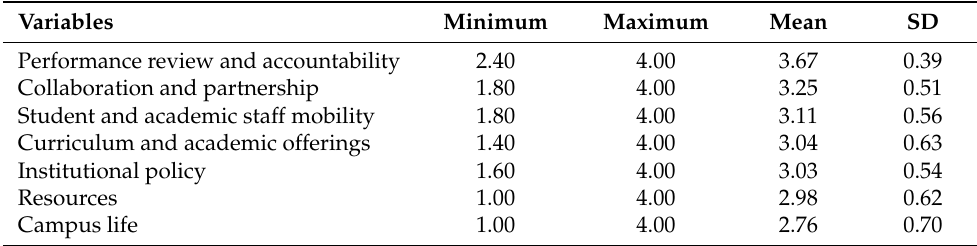
Table 2. Perceptions toward the seven performance indicators of